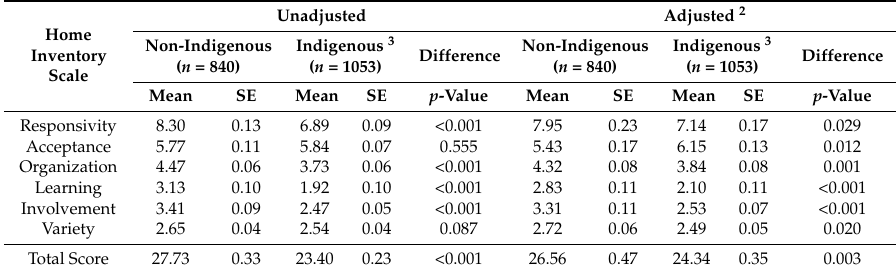
Table 3. Unadjusted and adjusted differences in HOME 1 Inventory scores between indigenous and non-indigenous communities ( n =